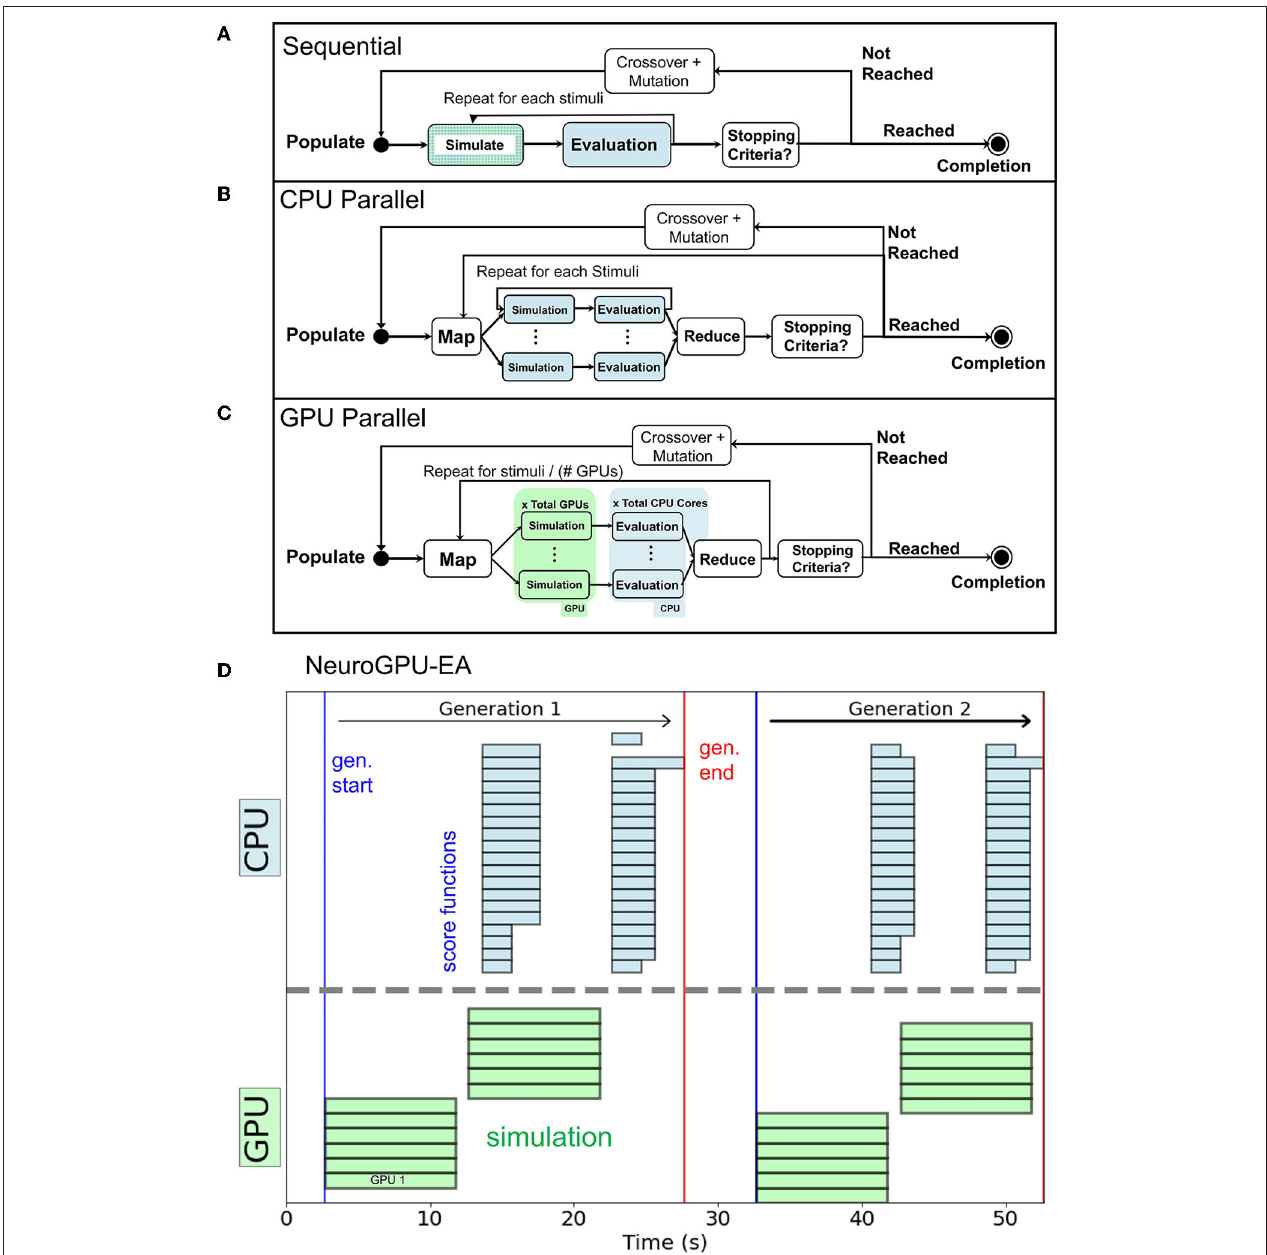
FIGURE 2 | (A) Sequential execution EA. (B) CPU-EA maps the simulation/evaluation of a model to a single core. (C) GPU-EA maps each stimuli to a GPU, then scores the simulation in parallel on each CPU core. (D) Timeline of NeuroGPU-EA for two generations. The algorithm starts new stimuli on GPUs while the CPUs are still completing the previous